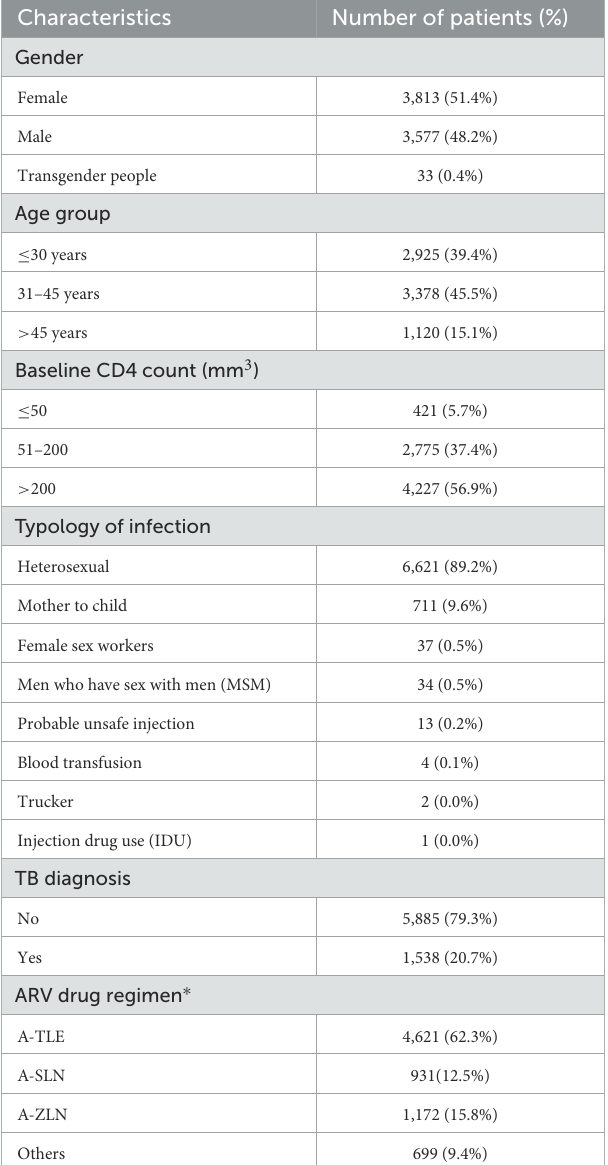
TABLE 1 Demographic and clinical characteristics of patients with HIV on ART ( N = 7,423). Characteristics